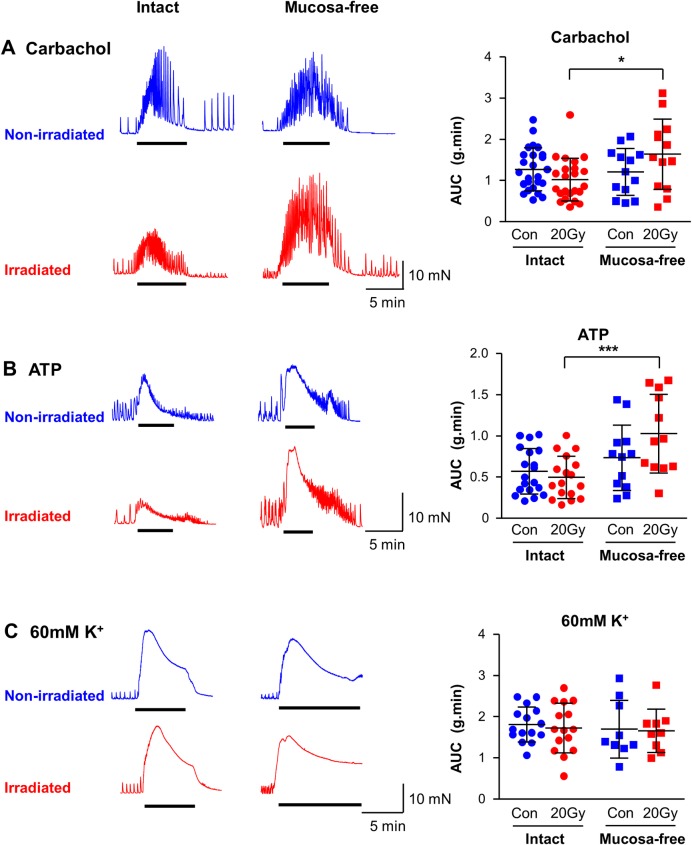
Irradiation and contractions evoked by carbachol, ATP and K+.(A) Representative carbachol (1μM) contractions in non-irradiated (blue) and 20Gy-irradiated (red), intact or mucosa-free bladder strips. Summary bar chart (mean ± SD) of force integral (AUC) showing that radiation did not affect carbachol-contractions in intact or mucosa-free strips. Interestingly, in irradiated strips, the mucosal layer apparently suppressed carbachol-contractions. * denotes P<0.05, unpaired t-test. Intact: non-irradiated, N = 17, n = 25; irradiated, N = 17, n = 23. Mucosa-free: non-irradiated, N = 7, n = 13; irradiated, N = 7, n = 13. (B) Representative ATP (5mM) contractions. Summary AUC bar chart shows ATP-contractions were unaffected by irradiation in intact or mucosa-free bladder strips. In irradiated strips, the mucosal layer apparently suppressed contractions (P<0.001). ***denotes P<0.001. Unpaired t-test. Intact: non-irradiated, N = 13, n = 19; irradiated, N = 13, n = 17. Mucosa-free: non-irradiated, N = 6, n = 12; irradiated, N = 6, n = 12. (C) Representative 60mM K+ contractions. Summary AUC bar chart shows these contractions were unaffected by irradiation in intact or mucosa-free strips. In contrast to carbachol and ATP, the mucosal layer had no impact on 60mM K+ contractions. Intact: non-irradiated, N = 12, n = 15; irradiated, N = 12, n = 15. Mucosa-free: non-irradiated, N = 5, n = 9; irradiated, N = 5, n = 9.